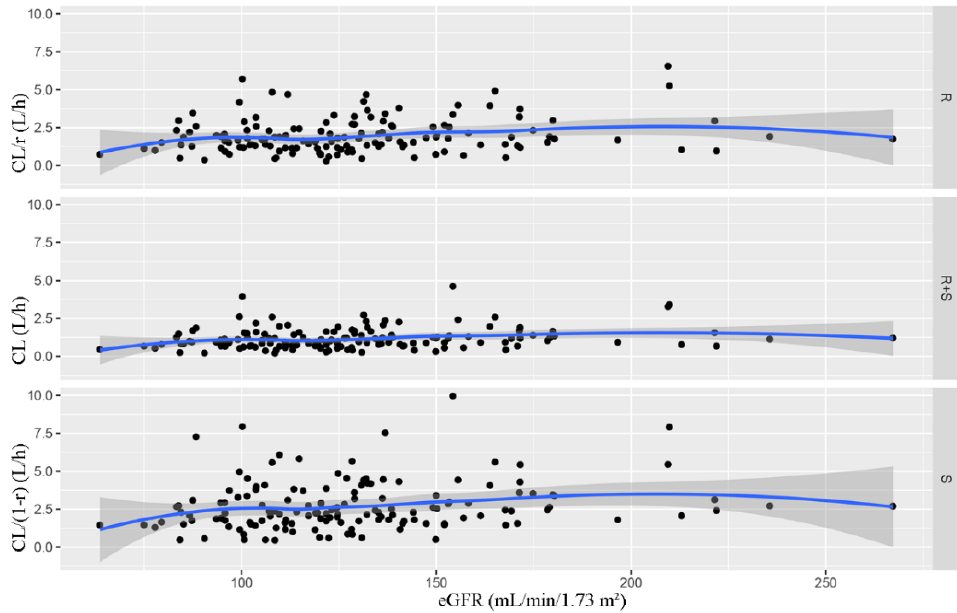
Figure 4. The CL of R/R + S/S latamoxef versus eGFR profile.